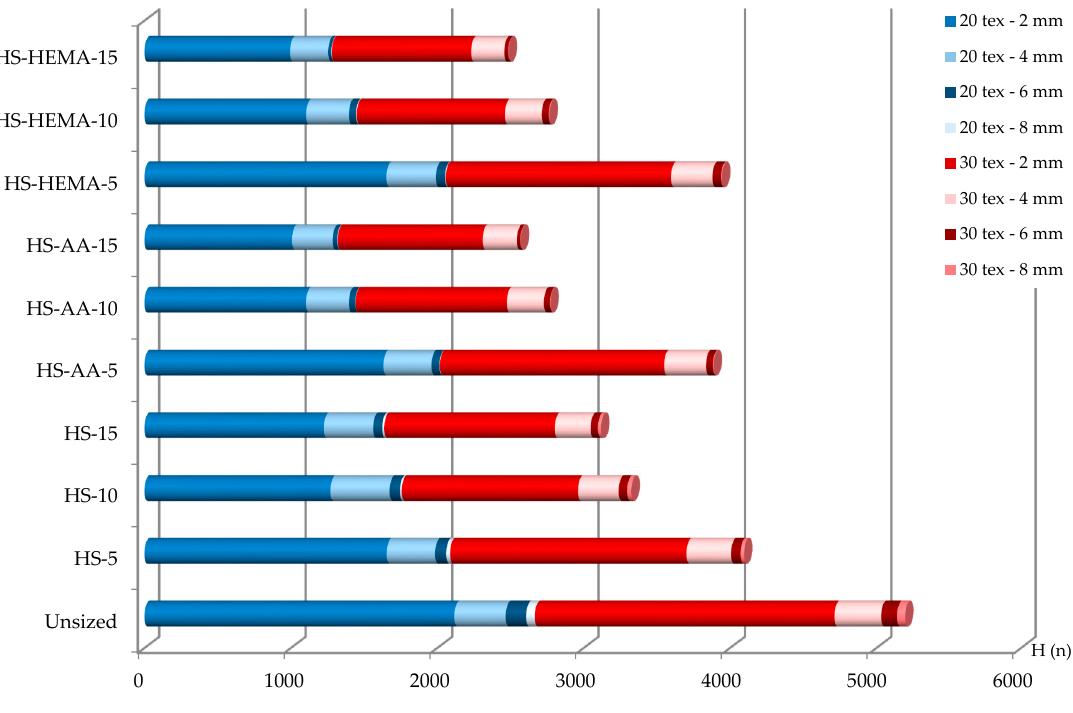
Polymers 2019 , 11 , x FOR PEER REVIEW Figure 11. Hairiness of the single yarn in the sizing process. Figure 11. Hairiness of the single yarn in the sizing process.